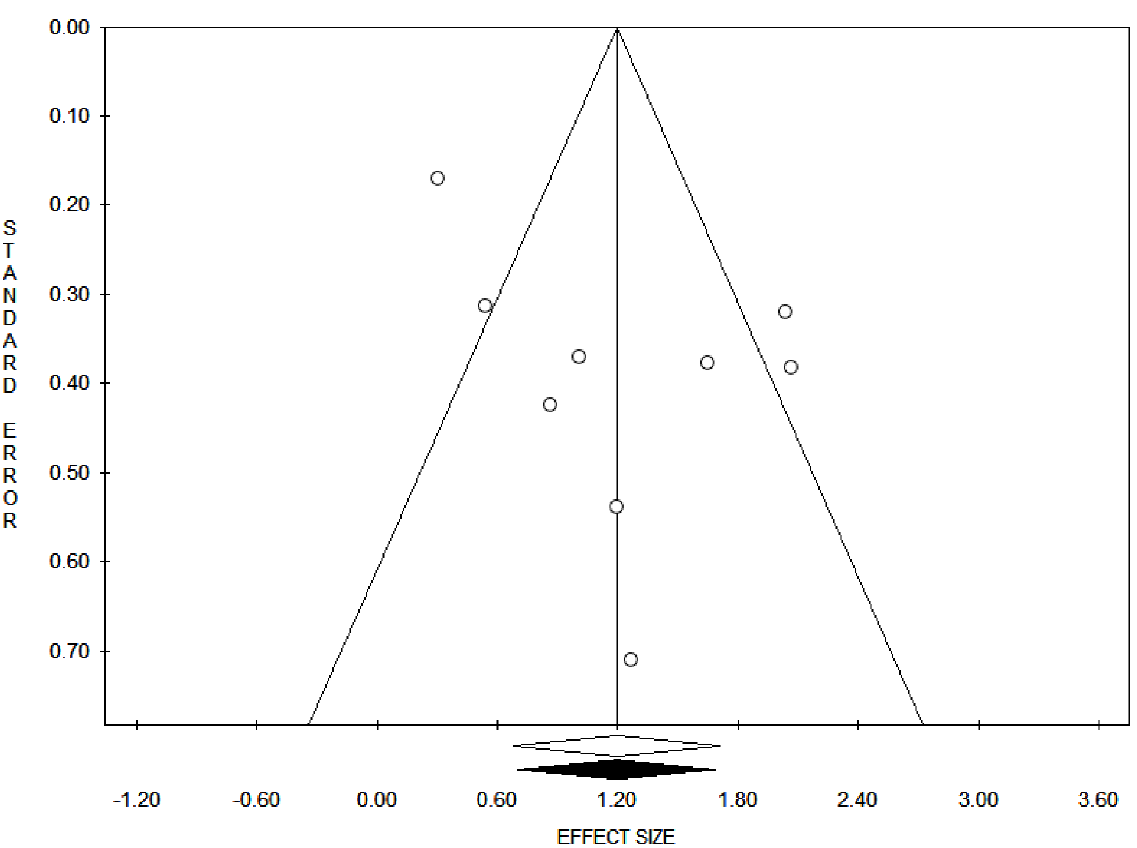
Fig 3. Funnel plot on having access to obstetric care facility within one hour’s travel